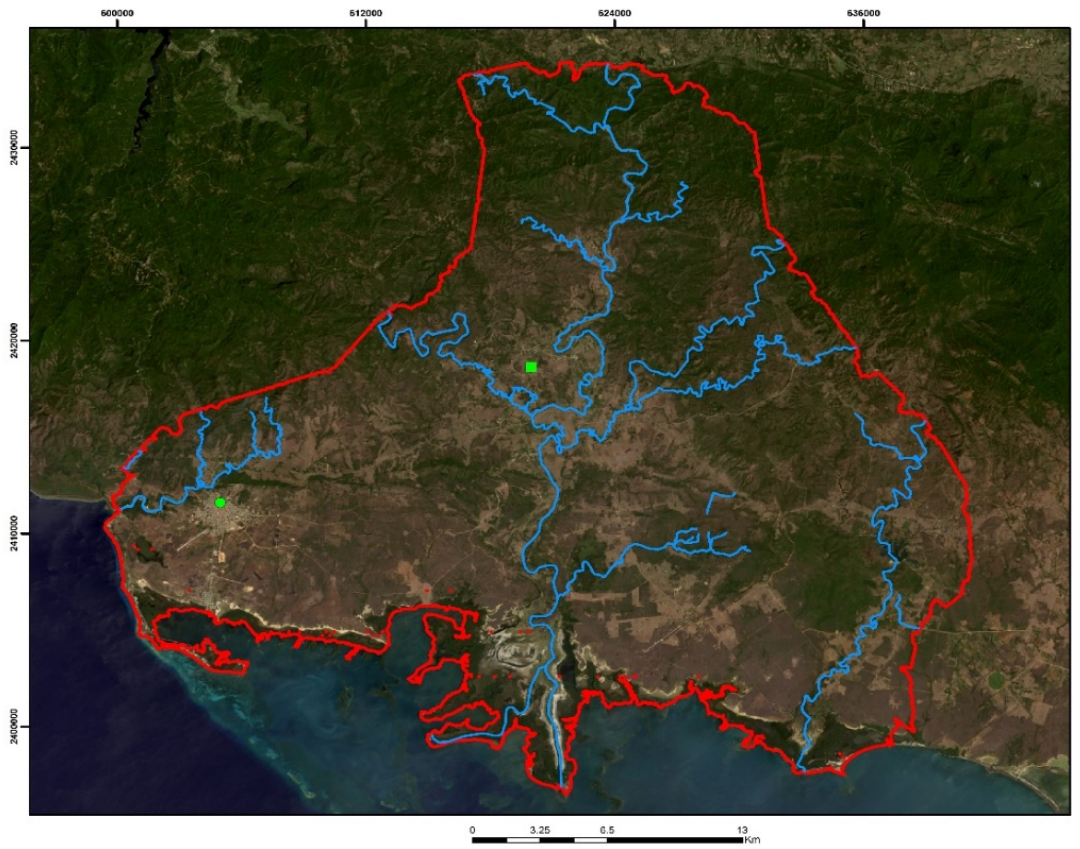
Figure 1. Trinidad-Valle de los Ingenios municipality in the Sancti Spiritus Province, Cuba (Landsat 8 image). Symbology: Town of Trinidad (green dot); Valle de los Ingenios (green square); rivers (blue lines). Datum: WGS1984; Spatial reference: UTM zone 17N; Latitude of origin: 0; Scale factor: 0.9996; Central meridian: − 81; False northing: 0; False easting: 500,000.